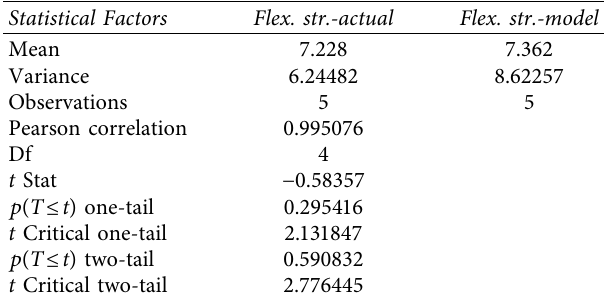
Table 30: T -Test: paired two-sample test for means for flexural strength